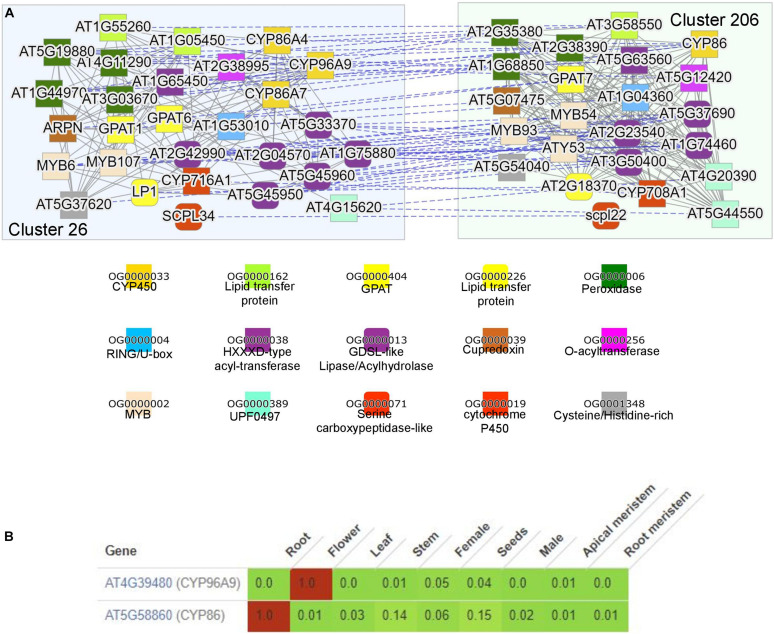
Comparison of the duplicated clusters involved in suberin and cutin biosynthesis. (A) Co-expression networks of module 26 (blue, left) and 206 (green, right) from Arabidopsis thaliana. The annotation of the colored shapes of the gene families (given as orthogroups OG) is shown below. (B) Expression profiles of At4g39480 from cluster 29 and At5g58860 from cluster 206. Green and red colors indicate low and high expression, respectively. The expression values are scaled by dividing each row by the maximum expression found in the row. The tool used is available at the “Tools/Generate heatmap/Comparative” on CoNekT’s homepage.